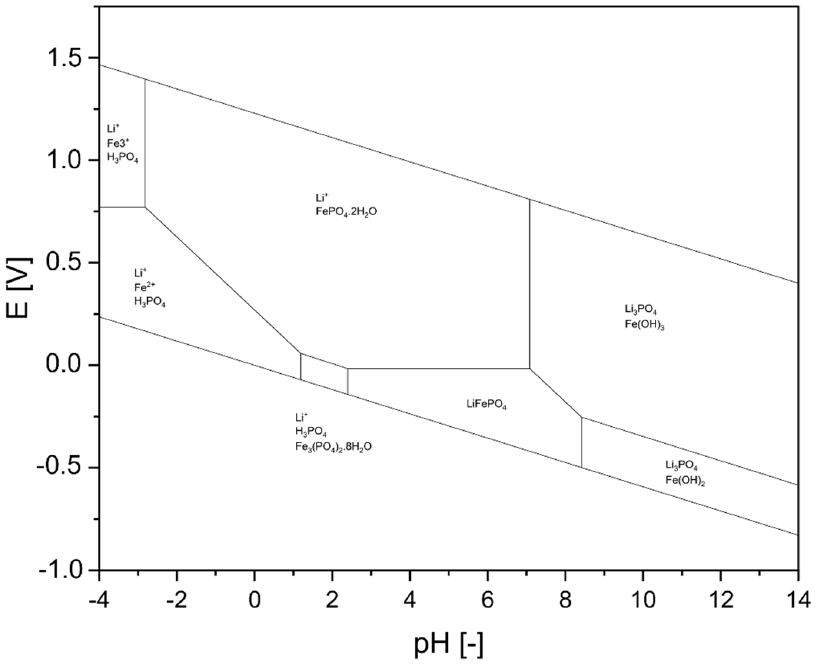
Figure 3. E–pH diagram for the system Li–Fe–P–H 2 O at 298.15 K and the hydrometallurgical recovery routes (I–III) of spent LFP [31].